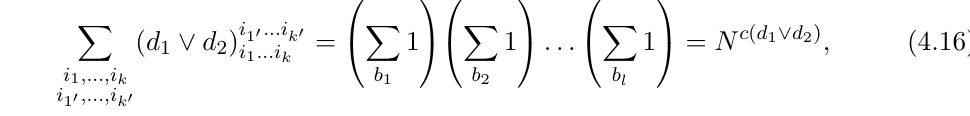
Figure 1 . By identifying the bottom vertices of d T of d T with the bottom vertices of d 1 , we have constructed a diagram with all the edges of d 1 together 2 with all the edges of d 2 . This is equal to the diagram d 1 ∨ d 2 . This figure is a central koan/insight of the factorization